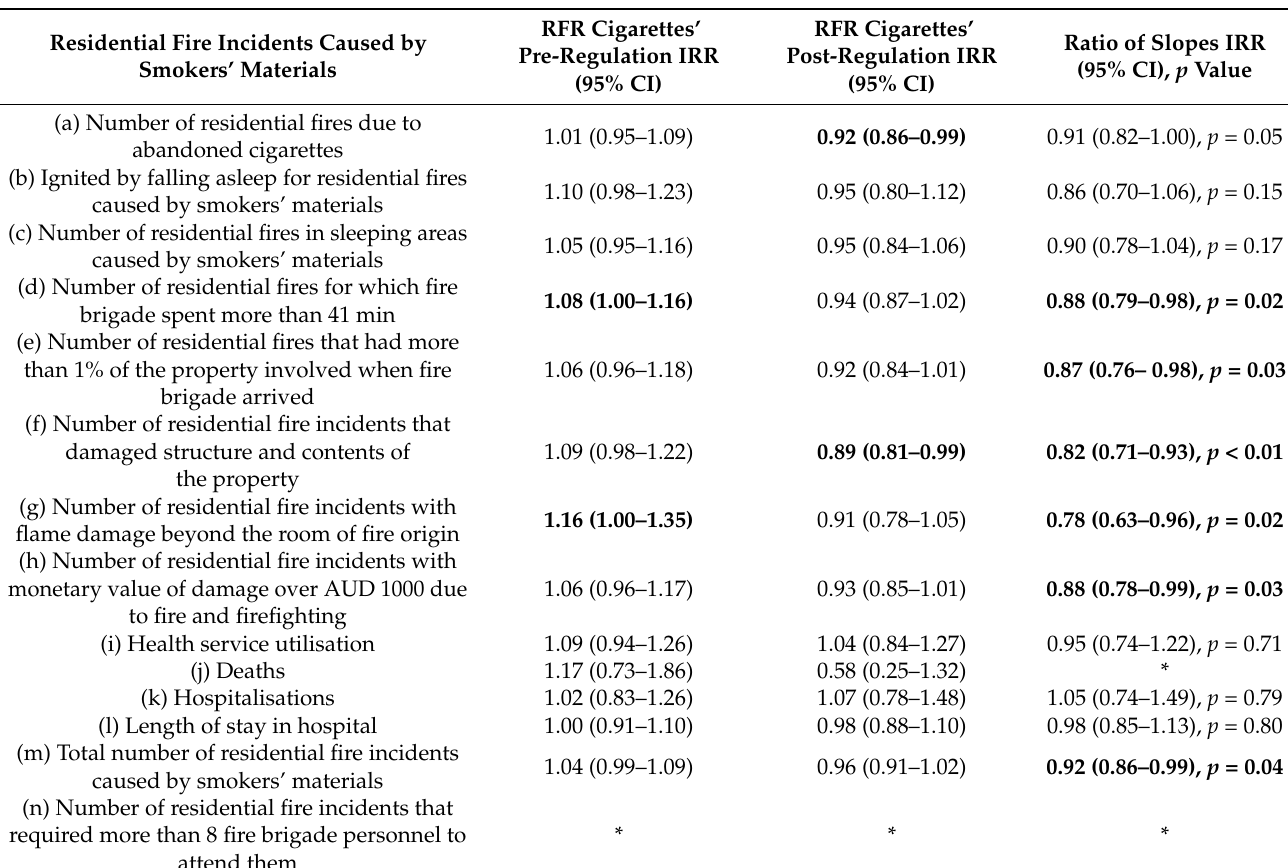
Table 2. Estimated effect of RFR cigarettes regulations in the number of smokers’ materials fires using linked data, NSW, Australia,